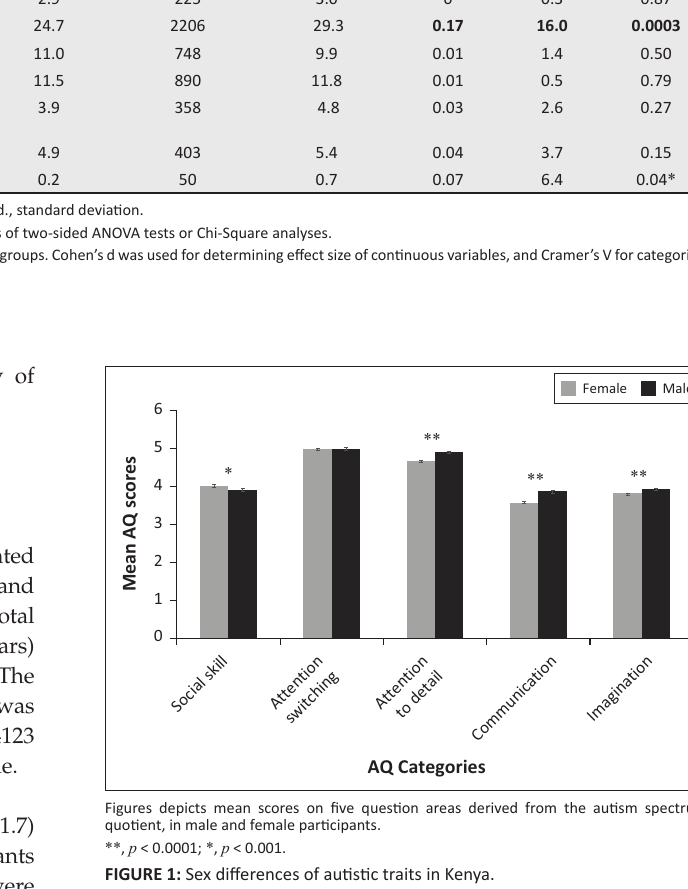
FIGURE 1: Sex differences of autistic traits in